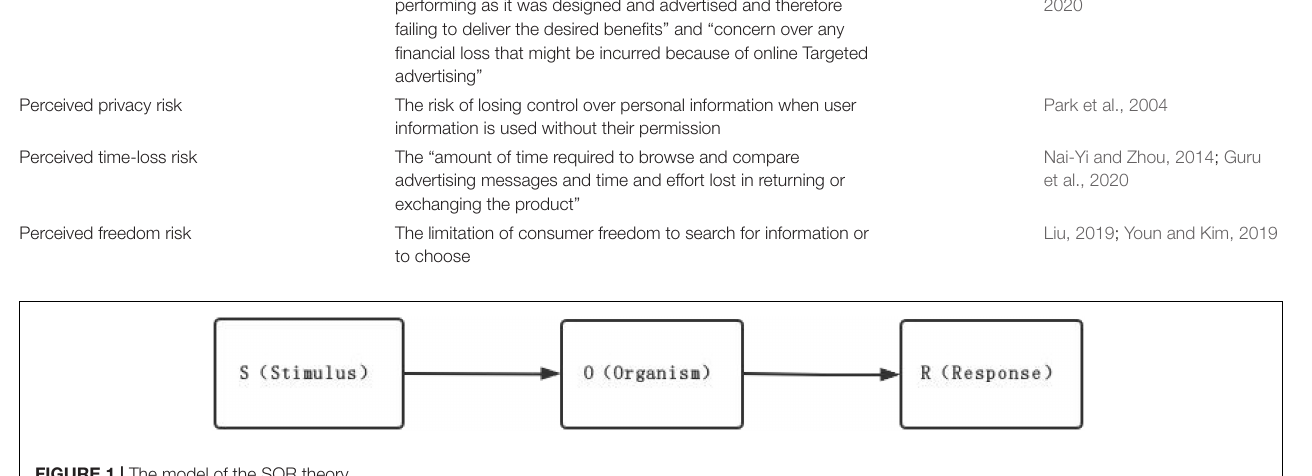
FIGURE 1 | The model of the SOR